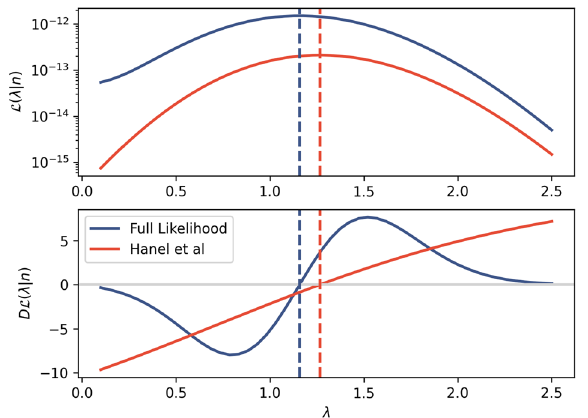
Figure 4. Likelihood functions of the full likelihood (blue) and only the leading term (red). Both likelihoods are calculated for the data n = [ 10, 3, 3, 2, 1, 1 ] . The leading term of the full likelihood is equivalent to the likelihood function as defined by Hanel et al. 10 , which is adapted for finite event sets from Clauset et al.’s estimator 8 . The top figure shows the full likelihood compared to Hanel et al.’s likelihood, with the maximum likelihood estimators shown as dashed lines. The bottom figure shows the differential of the likelihood functions. The form of the differential of the full likelihood is markedly different to only the first term. There is a substantial difference in the maximum likelihood estimator, with the Hanel et al. estimator giving ˆ (cid:31) = 1.27 and the full estimator giving ˆ (cid:31) = 1.16